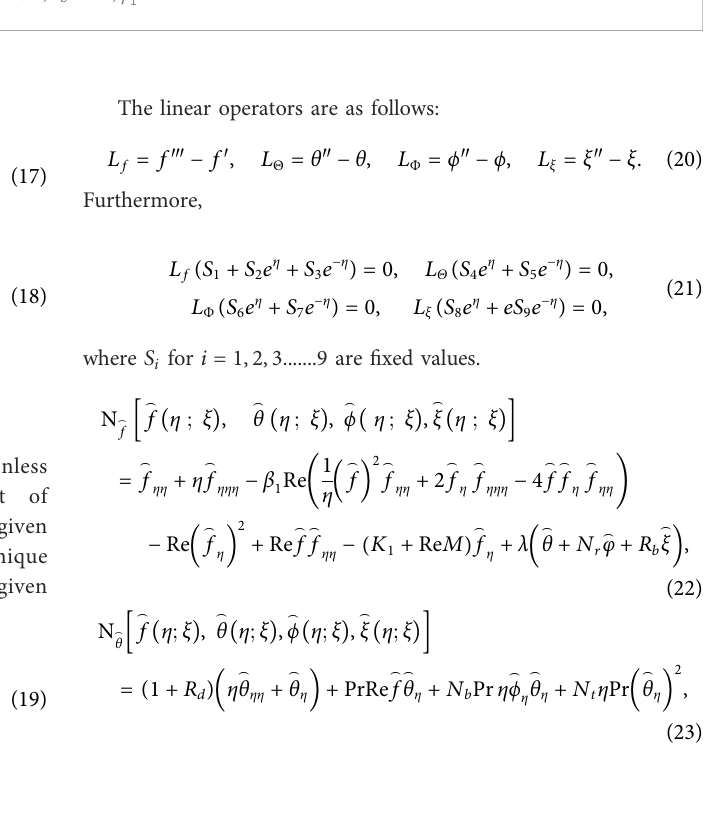
FIGURE 6 (A – D) : Impact of the magnetic fi eld on streamlines when Fr (cid:4) 0 . 1 , λ (cid:4) 0 . 2 , R b (cid:4) 0 . 1 , β 1 (cid:4) 0 . 1.